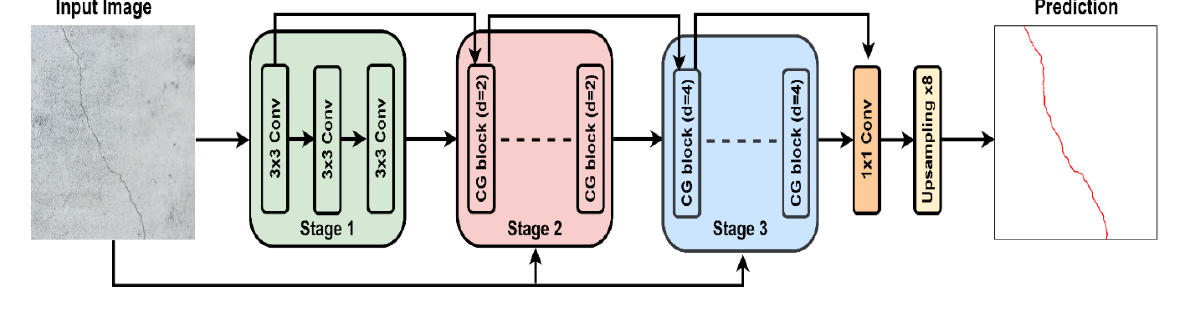
Figure 3. Overall architecture of